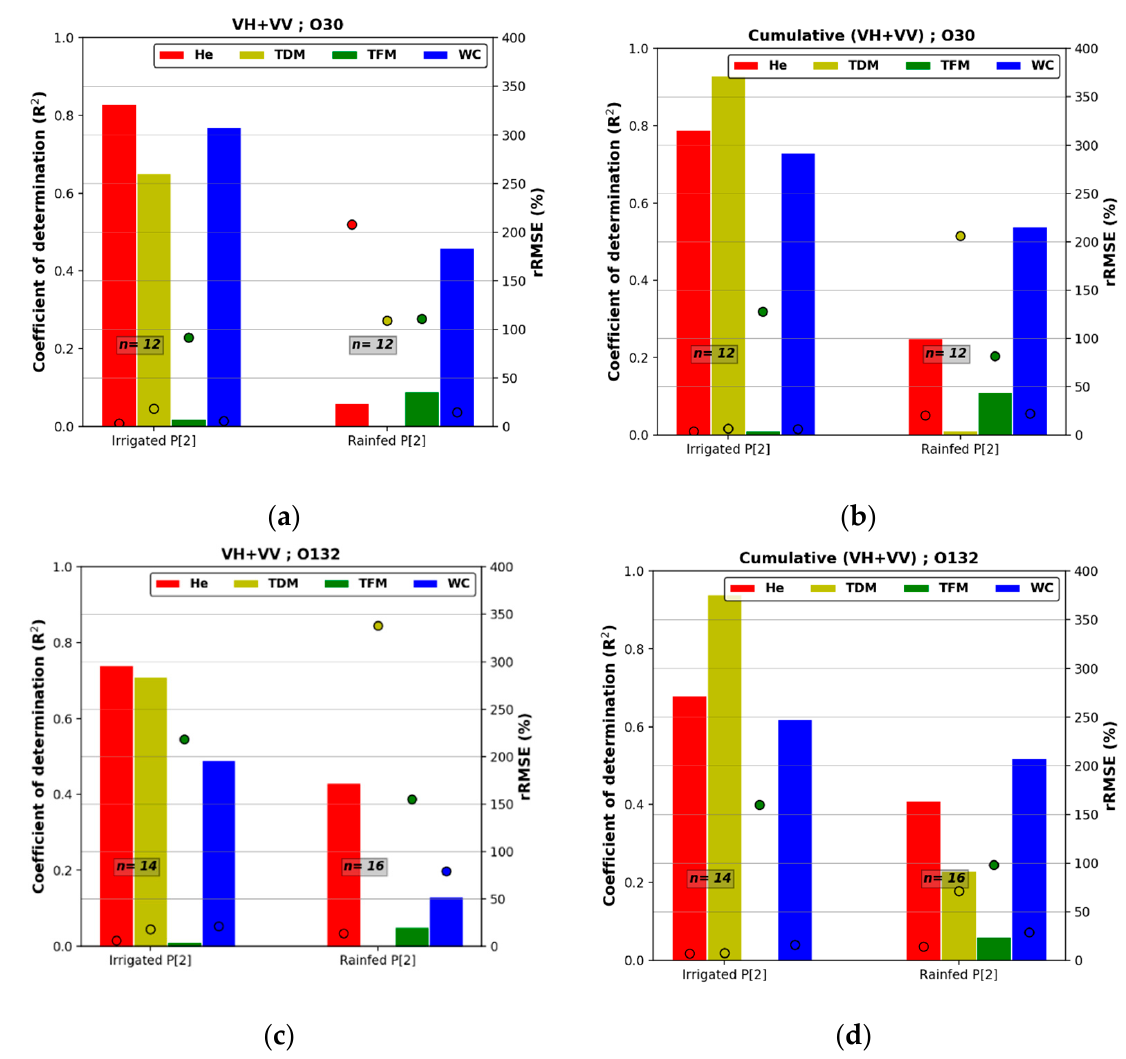
Figure 11. Correlations of the VH + VV ( a ) and ( c ) and its cumulative values ( b ) and ( d ) during the second vegetative period P [2]: Impact of phenological stages. Colored circles represent rRMSE values.